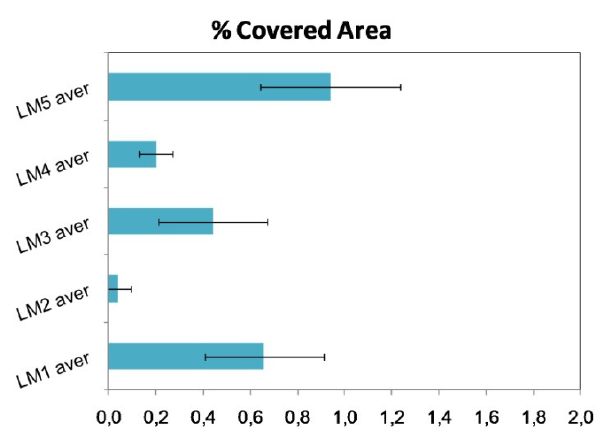
Fig. 6. Average percentage of area covered with particles ob- tained in the five indoor locations in the LTMCM. For abbrevia- tions see Table